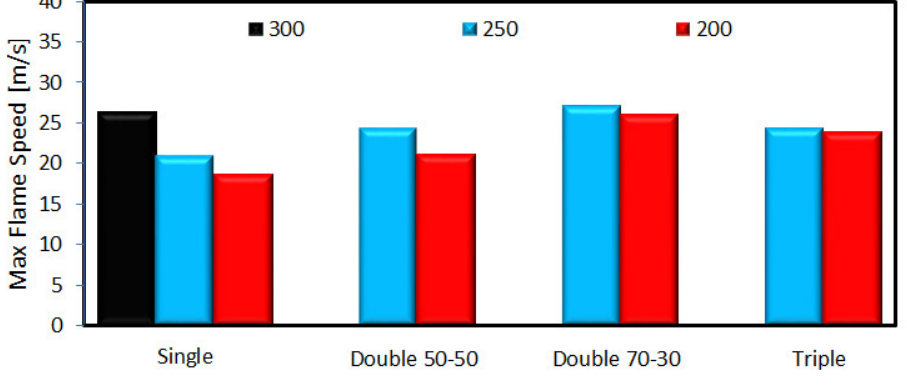
F igure 11. Maximum flame propagation